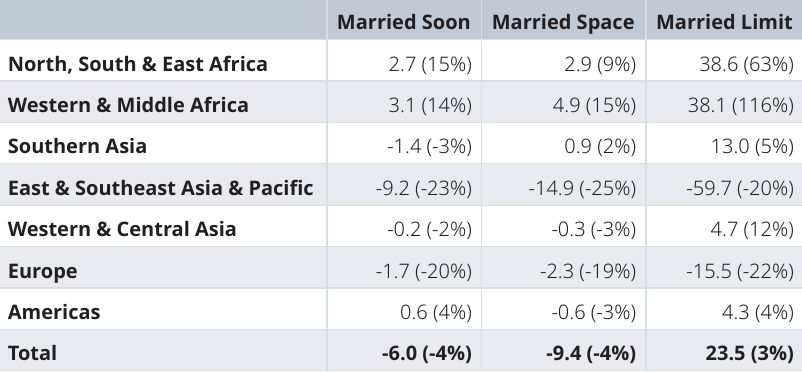
Table 4. Change in married women from 2020 to 2040 by market segment and region [abs change in millions (%